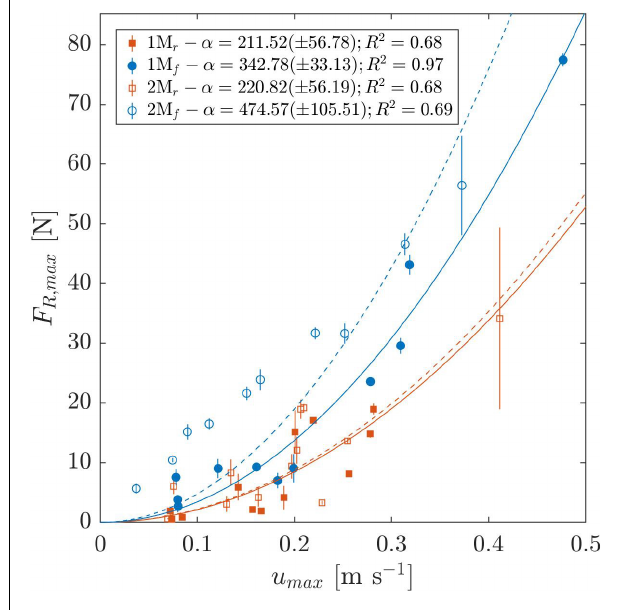
FIGURE 10 | Mean maximum resultant forces F R measured at front and rear anchors (subscripts f and r , respectively) of a 4-point anchored artificial seagrass mat. Filled markers correspond to the one-mat configuration (1M), void markers to the two-mat configuration (2M); error bars depict standard deviation ( n = 4–5). A quadratic fit of form F R = α u 2 max is shown for reference for each set of measurements with dashed lines representing 2M and solid lines 1M, respectively, color-coded according to the position f and r . The values for α and coefficient of determination ( R 2 ) are given beside the respective position in the legend. An additional fit for all front and all rear measurements (not plotted) yielded α = 384 . 12 ( ± 49 . 8 ) ; R 2 = 0 . 82 and α = 217 . 56 ( ± 36 . 71 ) ; R 2 = 0 . 69 for f and r , respectively.